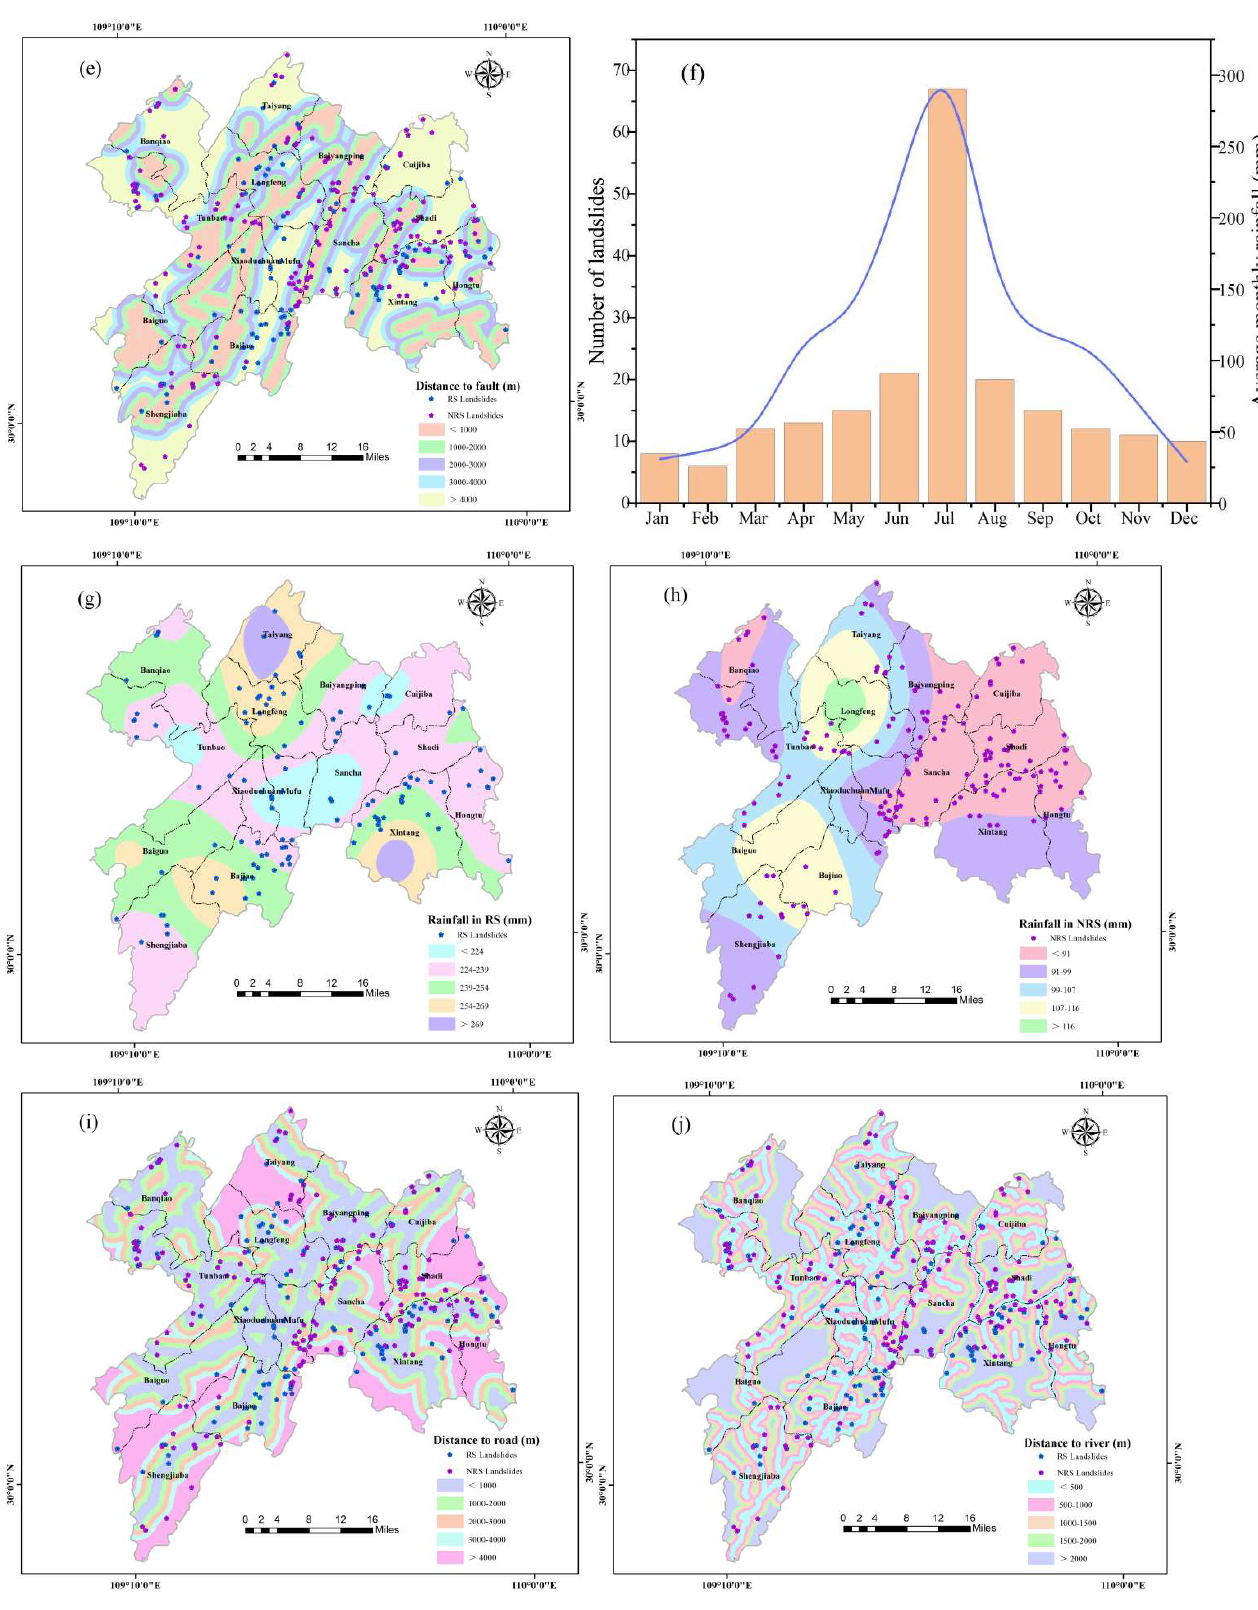
Figure 3. Assessment indicators partition in the study area: ( a ) elevation; ( b ) slope; ( c ) aspect; ( d ) lithology; ( e ) distance to fault; ( f ) plot of the number of landslides versus time; ( g ) rainfall in RS; ( h ) rainfall in NRS; ( i ) distance to road; ( j ) distance to river.